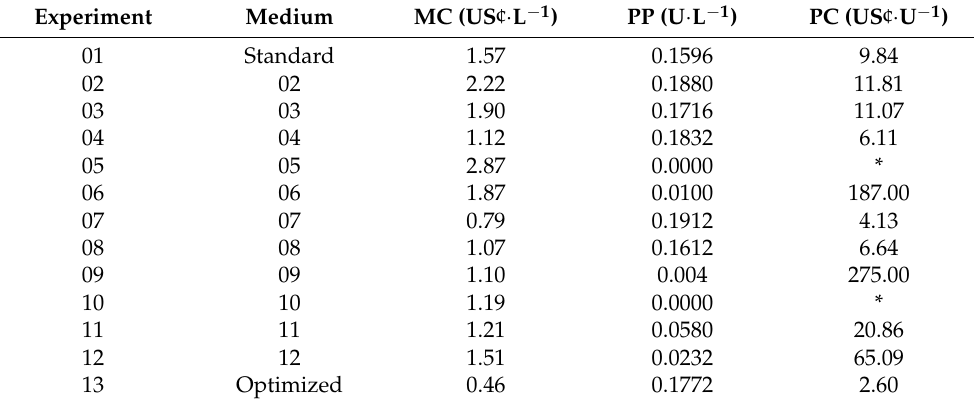
Table 5. Culture medium cost (MC), ALDC activity per liter of culture medium (PP), and production cost of ALDC (PC) for each culture medium used for enzyme production by Bacillus subtilis ICA 56. MC is expressed in dollar cents per liter (US